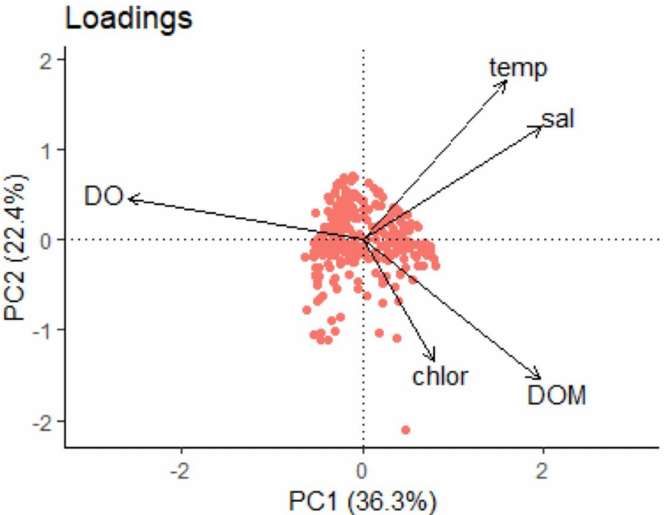
Figure 3. PCA of environmental conditions in mid- and deep water in Almirante Bay, showing the coupled relationships between salinity (sal) and temperature (temp), as well as chlorophyll (chlor) and